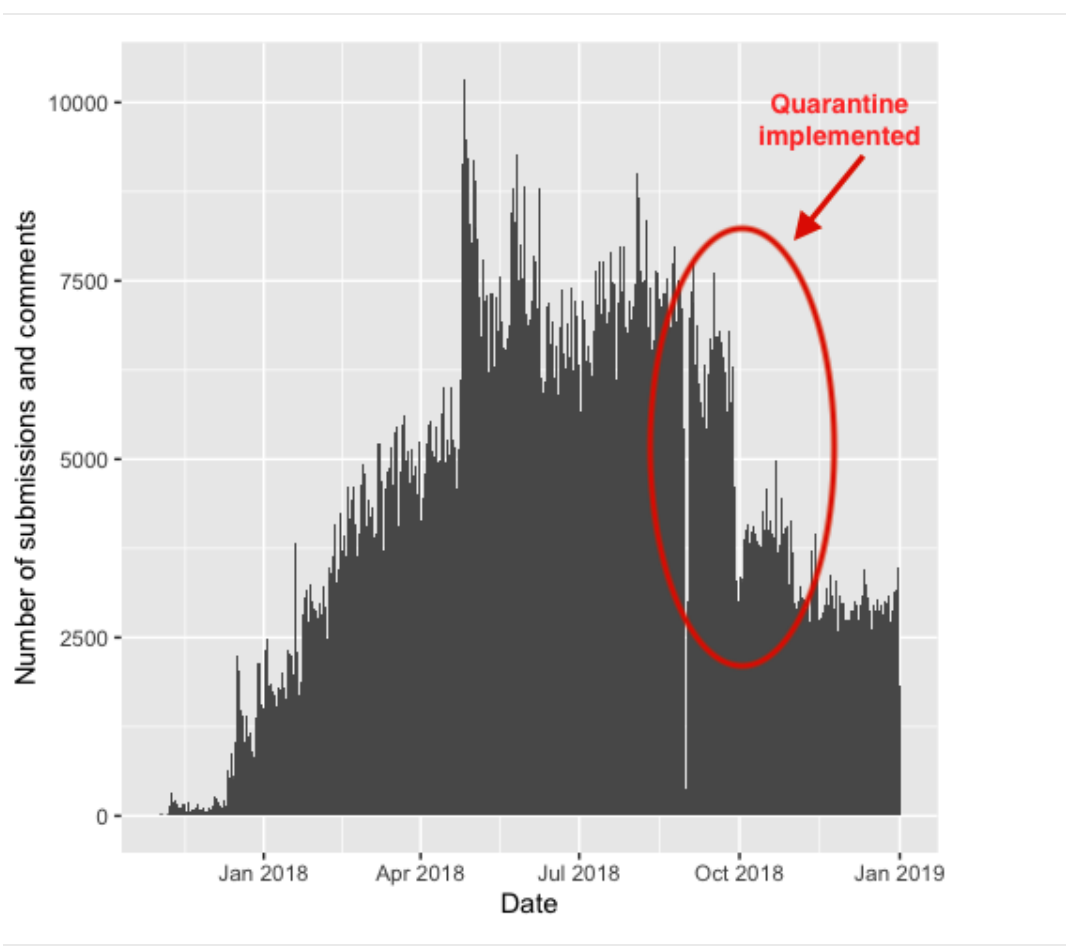
FIGURE 3: The Braincels submissions and comments frequency